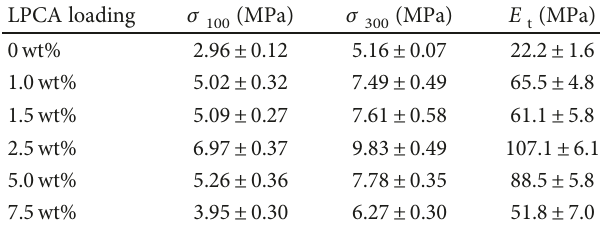
), tensile stress at 300% strain ( σ 100 Table 4: Tensile stress at 100% strain ( σ strain ( σ ) and modulus of elasticity in tension ( E 300 WPU elastomers with di ff erent loadings of